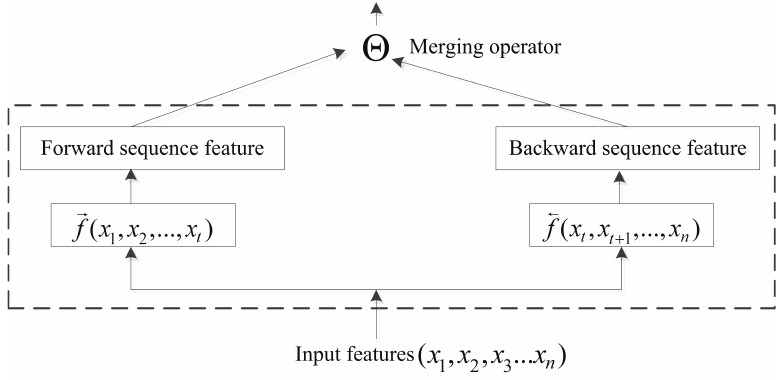
Figure 4. In order to remember more long-range information in the sequence study, when the past computing information and the future computing information are merged, the merging operator is proposed to execute the merging